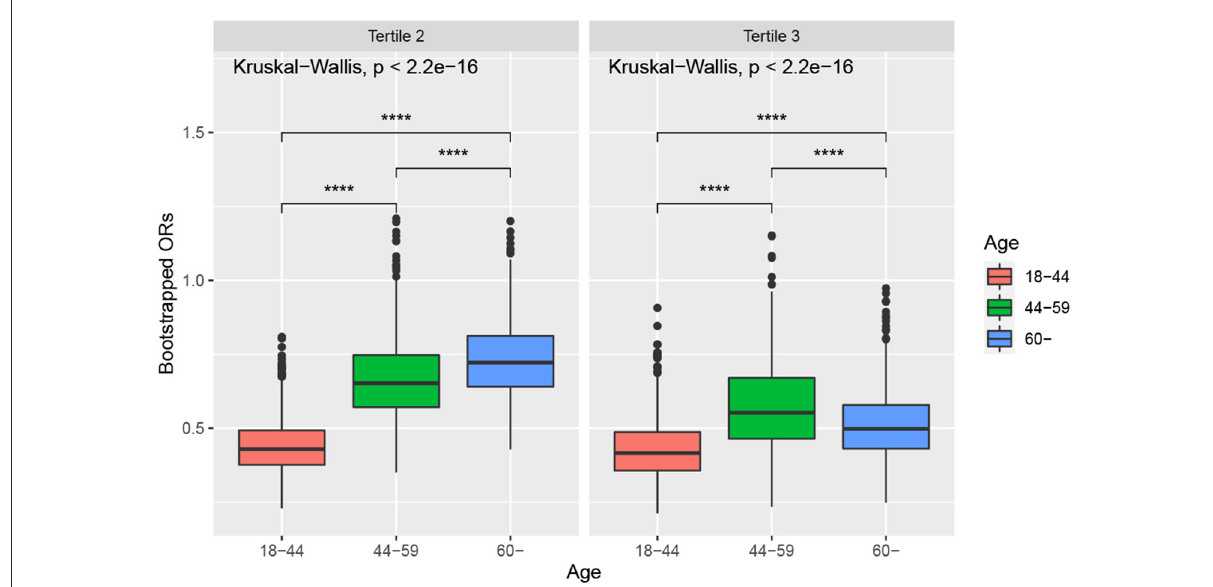
FIGURE3 Boxplot of bootstrapped ORs by age. The model was adjusted for sex, race, educational level, marital status, annual family income, BMI, caffeine intake, total energy intake, hypertension, diabetes, smoking status, drinking status, sedentary activity, and total activity per week. Note: